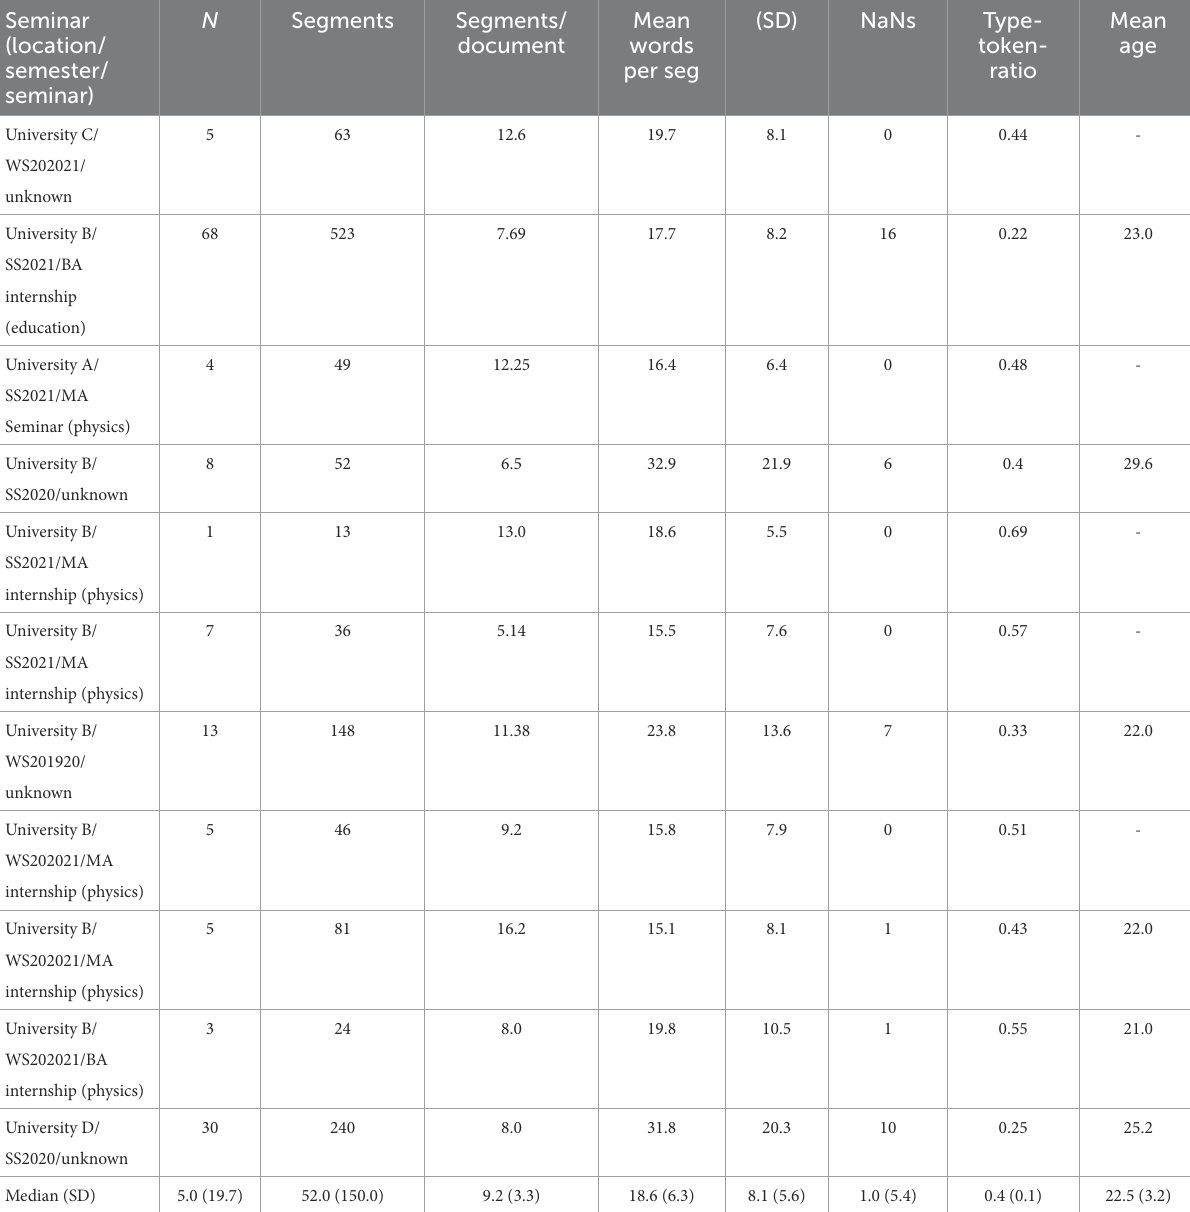
TABLE 1 Descriptive overview of the various samples that were considered in this